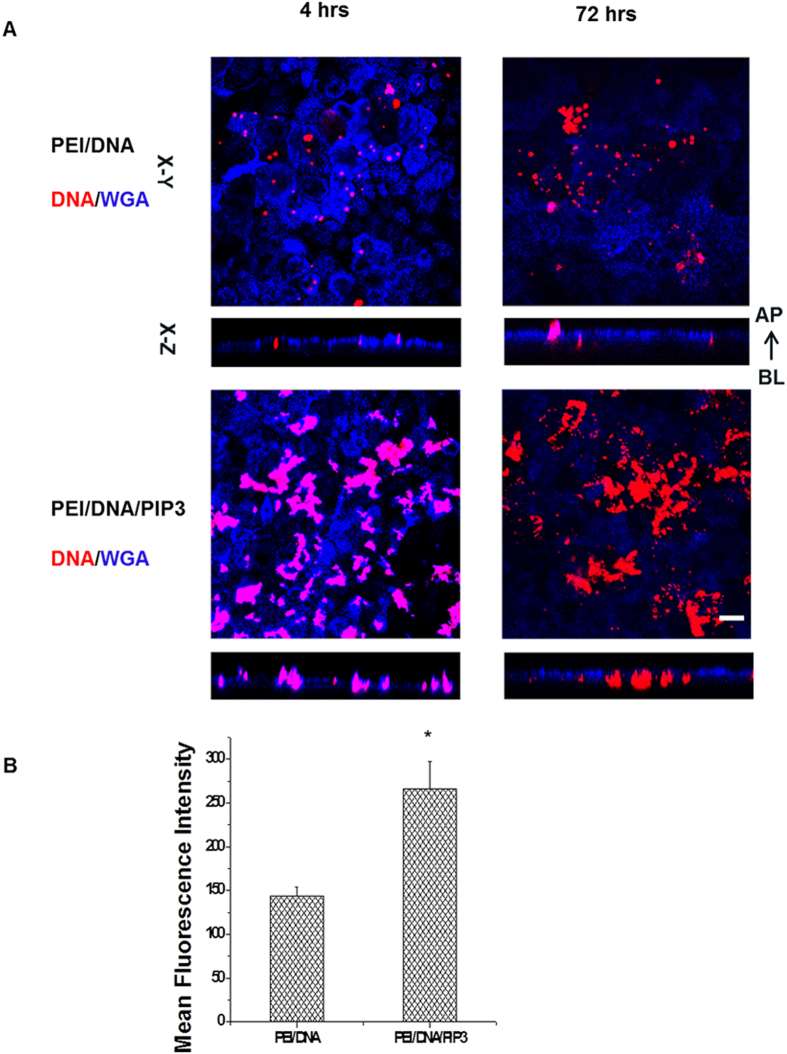
Binding and uptake efficiency of PEI/PIP3 and PEI polyplexes by MDCK cells after 4 hours and 72 hours incubation.(A) MDCK cells were incubated with complexes for 4 and 72 h, after which the apical plasma membrane was stained with WGA-Alexa Fluor 633 conjugate (blue). Plasmid DNA was labeled by Cy3 (red). Pink (blue + red) color indicates binding of complexes at the apical plasma membrane. Red color indicates internalization of complexes. Scale bar 10 μm. (B) The mean fluorescence intensity of the MDCK cells, representing the fraction of internalized Cy3-labeled polyplexes, was quantified after 72 hours by FACS analysis. Two-tailed t-test was used to determine statistical difference between each treatment group and control. *p = 0.003.